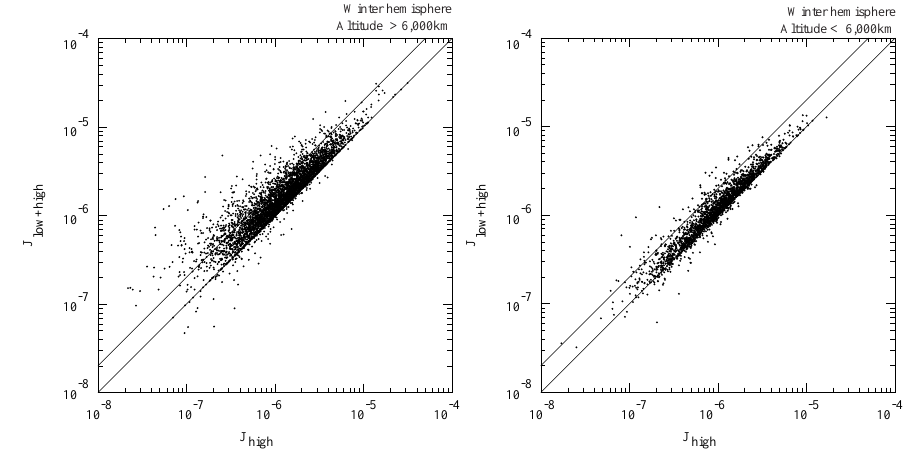
+ high versus J high obtained at high altitudes (above 6000km) and low altitudes (below 6000km), respectively. e − e −